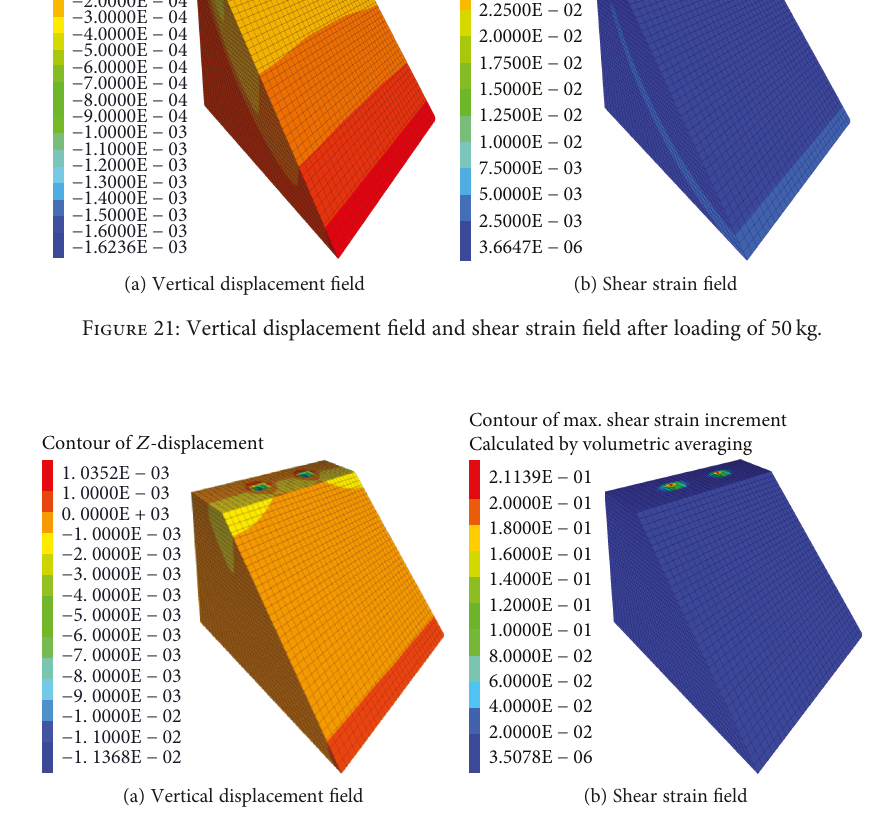
Figure 22: Vertical displacement fi eld and shear strain fi eld after loading of